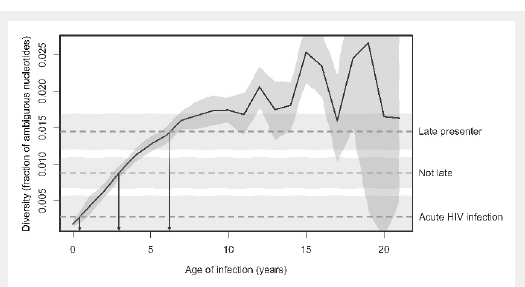
Relationship between the year of infection and the fraction of ambiguous nucleotides. The solid black line represents the mean fraction as a function of the age of infection, where data points have been binned according to the age of infection in years (n = 3,307 patients). (Figure adapted from [18] Roger D. Kouyos et al.: Ambiguous Nucleotide Calls From Population-based Sequencing of HIV-1 are a Marker for Viral Diversity and the Age of Infection, Clinical Infectious Diseases, 2011, 52(4):532–539, by permission of Oxford University Press.) The dashed horizontal lines depict the mean fraction from the three groups of our study and the shaded area represents the 95% confidence intervals. The three arrows from the intersections of the curve with the horizontal lines point to estimated durations of HIV infection of approximately 6, 3, and <1 years for the three